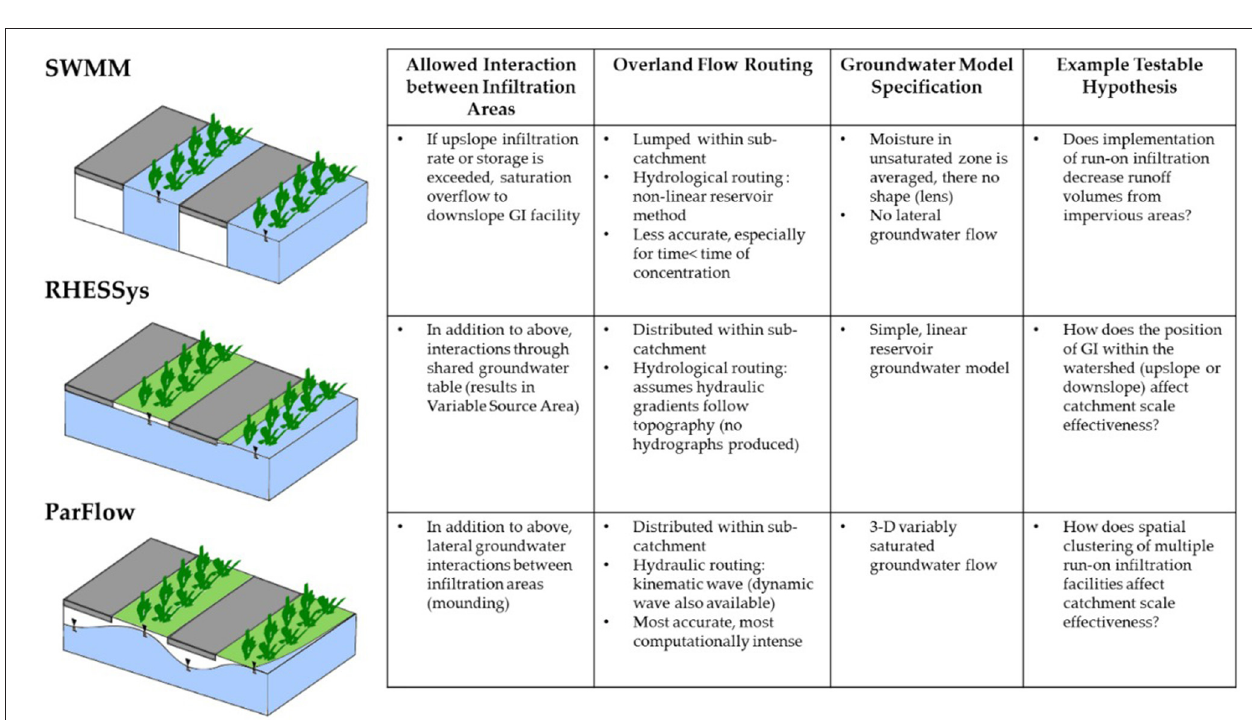
FIGURE 1 | Conceptual model of factors influencing areas contributing runoff in an urbanized catchment area (adapted from Lim, 2016). Conventional and green infrastructure placement and density mediates balance between dominance of Hortonian flow, saturation overland flow, and subsurface stormflow processes at the catchment scale. Red dots indicate processes that are hypothesized to be dependent on antecedent wetness conditions and multiday events.